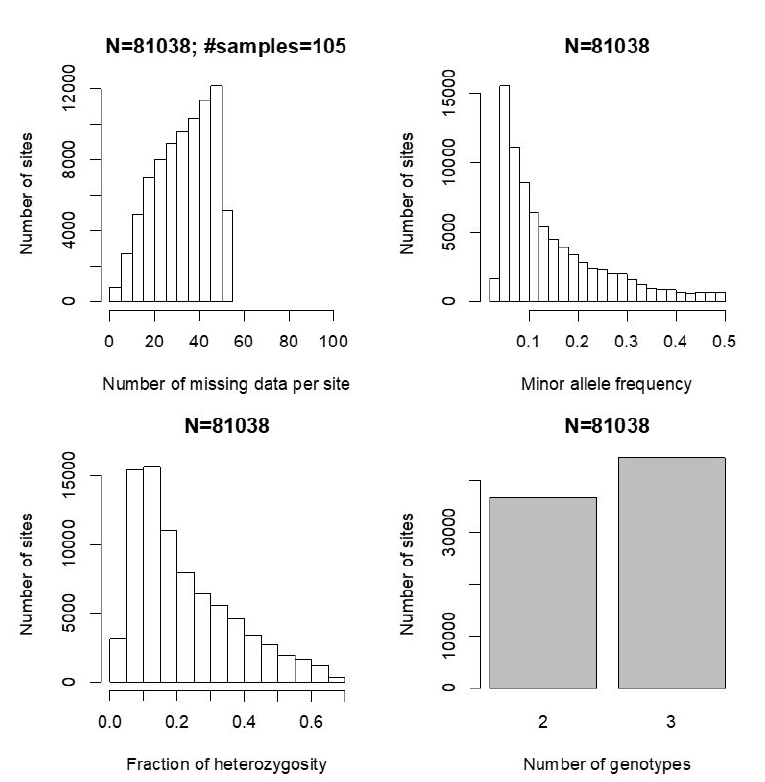
Figure 1. Site-based, low missing data (LMD) single nucleotide polymorphisms SNPs genotype summary. Distribution of missing data, minor allele frequency, heterozygosity, and genotype number are used to describe the LMD SNPs